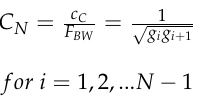
Fig. 4. The proposed n th coupled resonator bandpass - filter